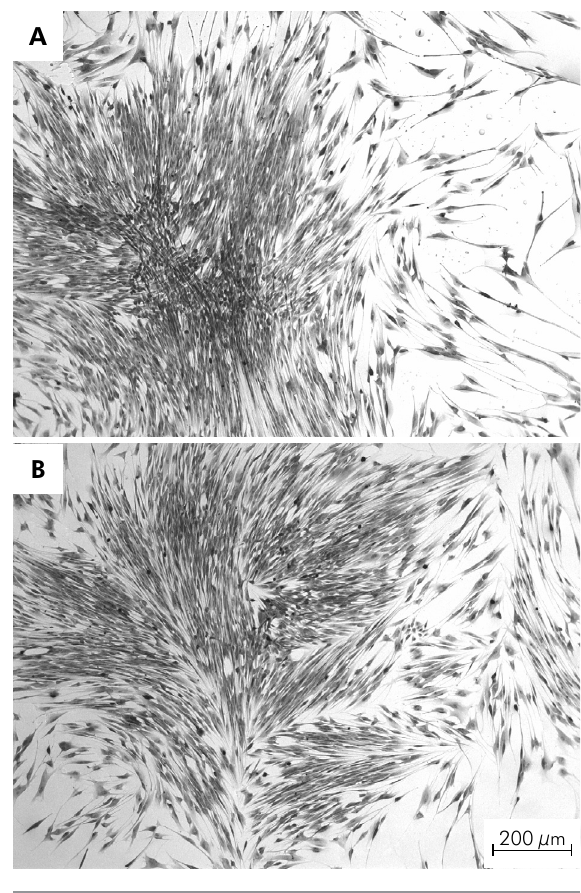
Figure 1. Illustrative phase micrographs of dental pulp cells presenting colony-forming activity stained with